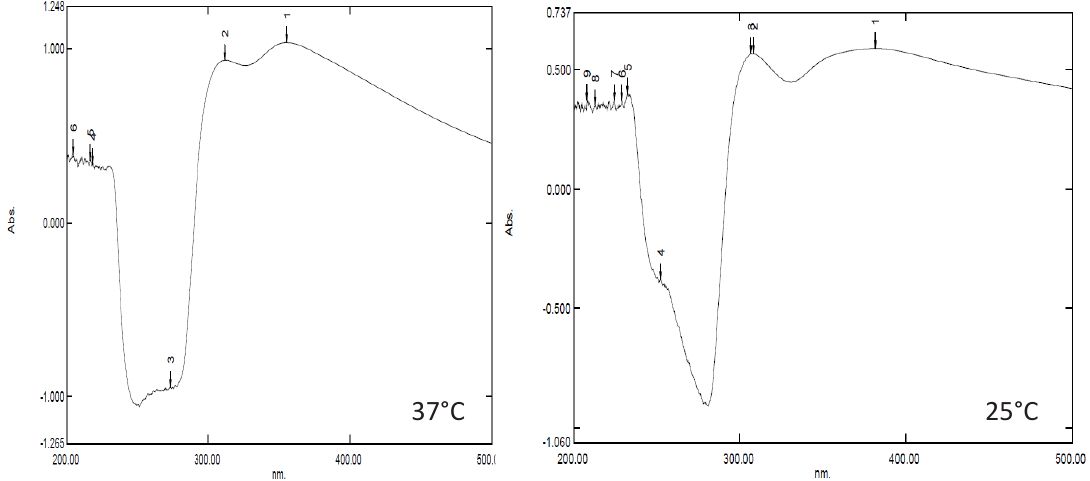
Fig. 4. UV-vis spectrum of silver nanoparticle produced by Escherichia coli at temperature 37 0 C and 25 0 C